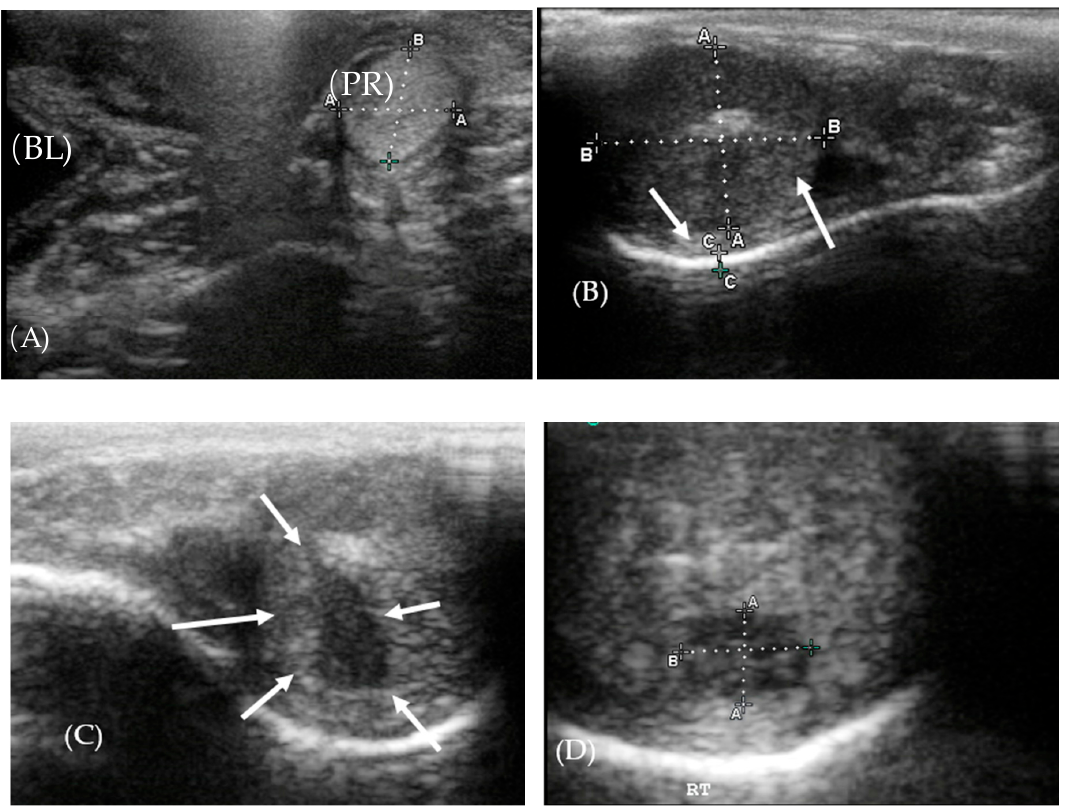
Figure 1. Ultrasonography of the testis and prostate. ( A ) The prostate gland (PR) was isoechoic to the bladder (BL). ( B ) Right testis of Leopard 1 showing the hydrocoele (solid arrow) and fibrosis (dashed arrow), beneath the tunica albuginea. ( C , D ) Hypoechoic area in the testis of Leopard 2 (solid arrows).